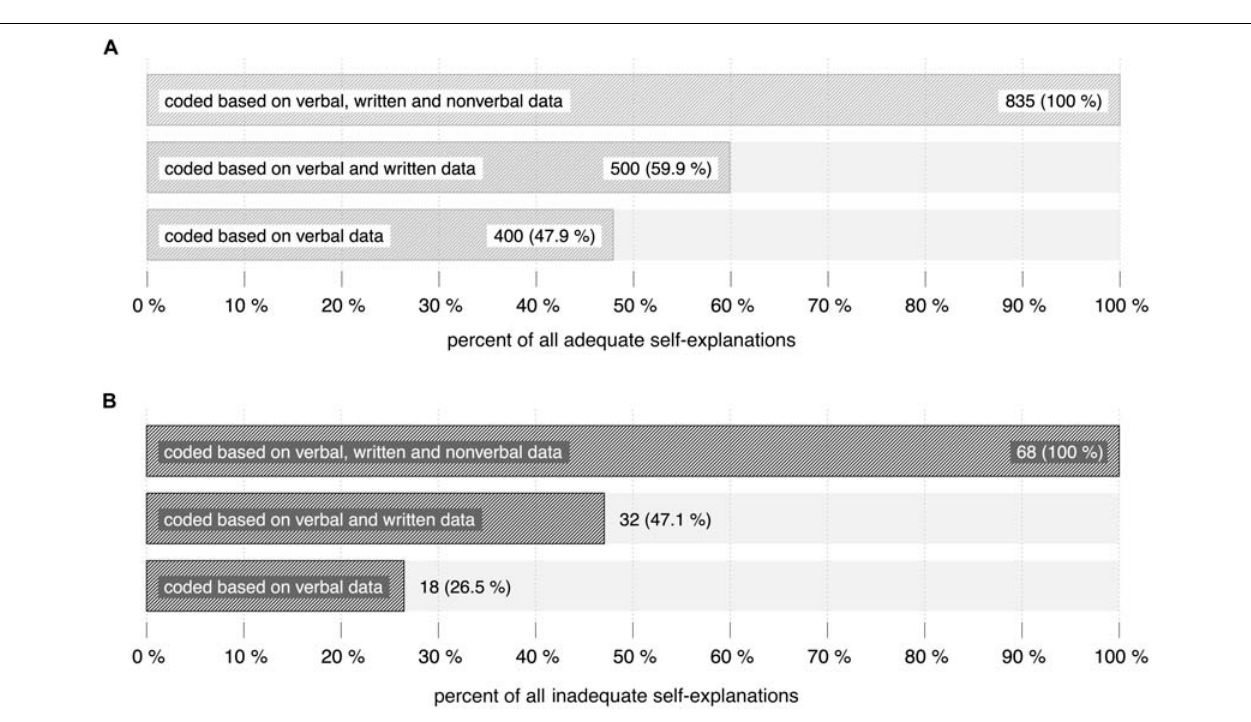
FIGURE 8 | Data used to code adequate (A) and inadequate (B) self-explanations. The first row depicts the proportion based on verbal, written and non-verbal data. The second row depicts the corresponding proportion based on verbal and written data. The third row depicts the proportion of adequate self-explanations that were coded based on verbal